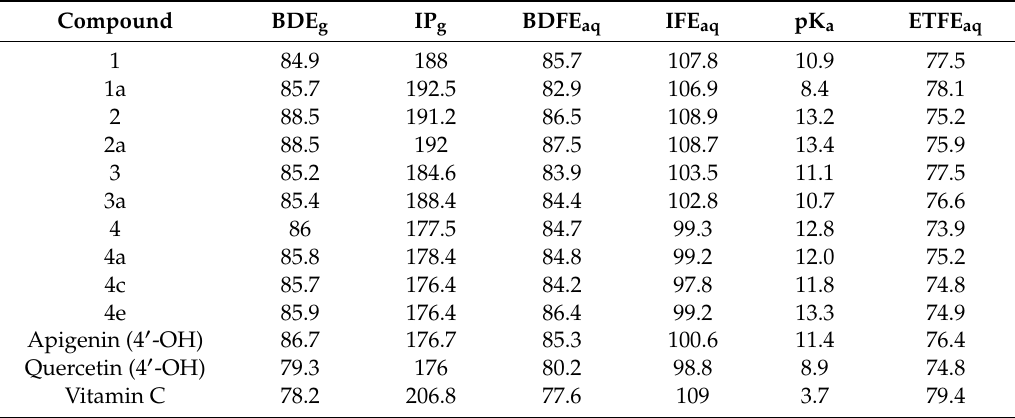
Table 2. Computed parameters (in kcal / mol) of O–H bond dissociation energy in the gas (g) and aqueous (aq) phases (BDE g , BDFE aq ) and the electron donating capacity (ionization potential and electron transfer free energy) (IP g , ETFE aq ) as well as acidity (pK a ) of studied derivatives with unsubstituted pyrazine ring A (a) and corresponding chalcones, the guaiacyl derivatives 4c and 4e in addition to well-known antioxidants. Compound BDE g IP g BDFE aq IFE aq pK a ETFE aq